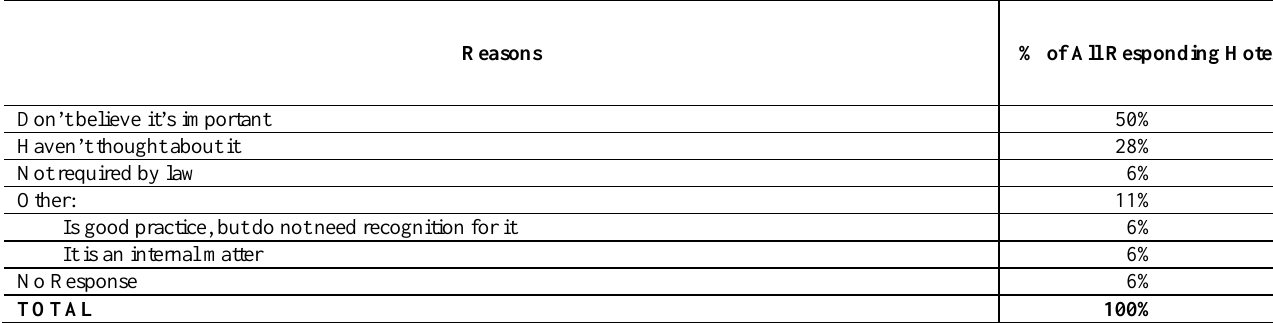
Table 5: Reasons respondents do not include information about their responsible tourism policy in their marketing